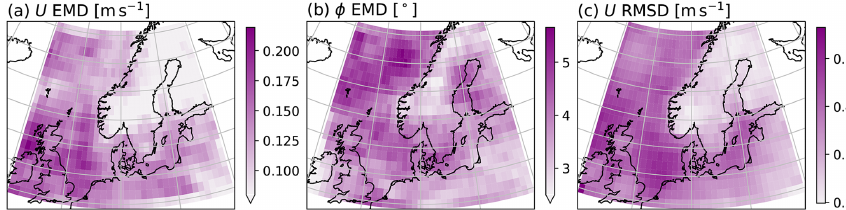
Figure 9. Median of the ensemble of (a) EMD of the 100ma.g.l. wind speed (ms − 1 ), (b) CEMD of the 100ma.g.l. wind direction ( ◦ ]), and (c) RMSD of the annual cycle (ms − 1 ) between the past (1995–2014) and future (2031–2050) in the various CMIP6